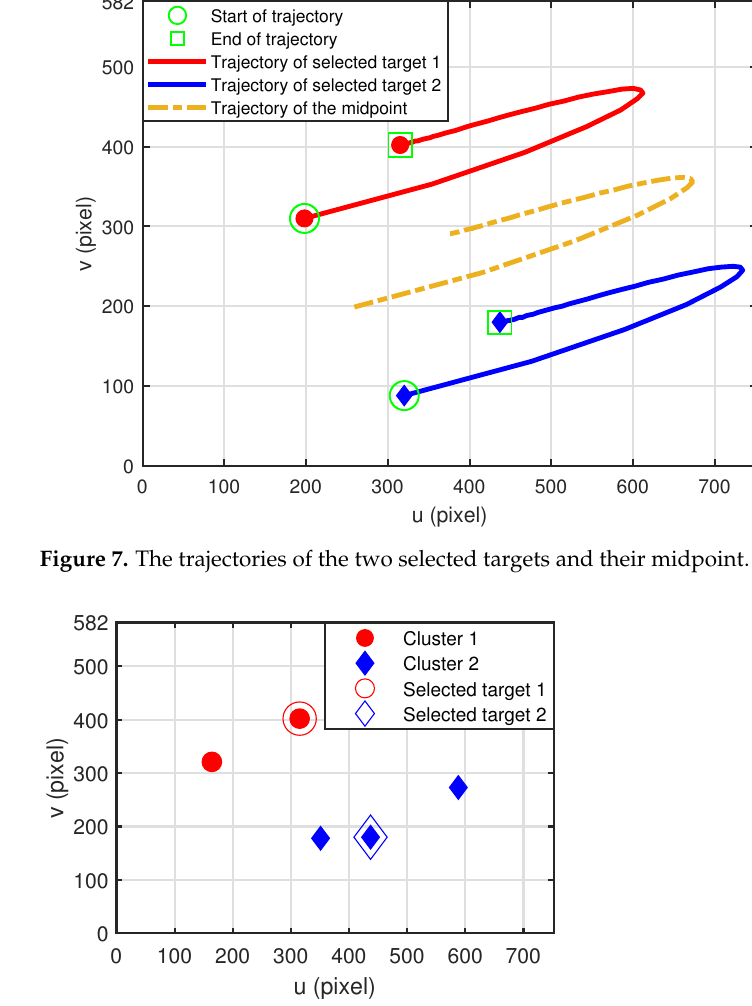
Figure 8. The final target